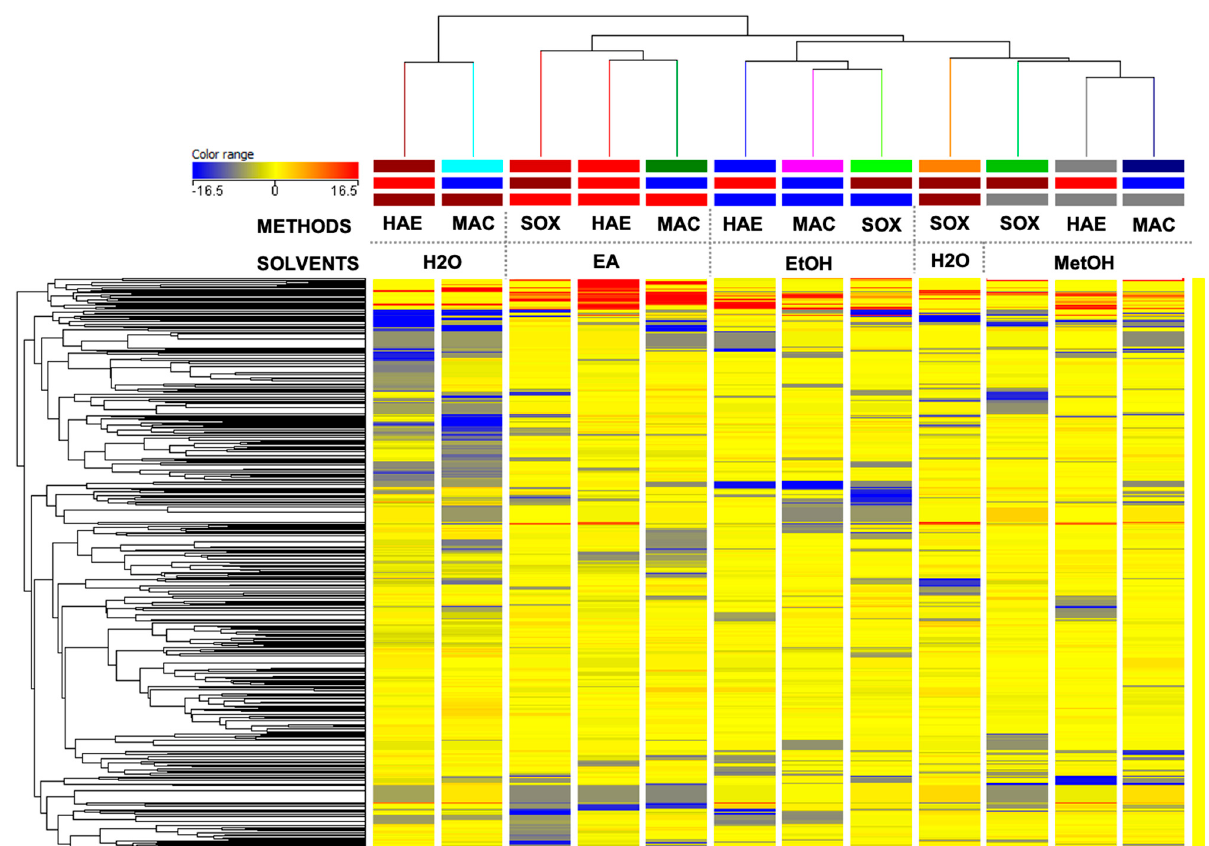
Figure 1. Unsupervised hierarchical cluster analysis of bioactive compounds considering three methods of extraction: homogenizer-assisted extraction (HAE), maceration (MAC), Soxhlet (SOX), and four solvents: ethyl acetate (EA), methanol (MetOH), ethanol (EtOH), and water (H 2 O) of metabolites profile of R. angustifolius